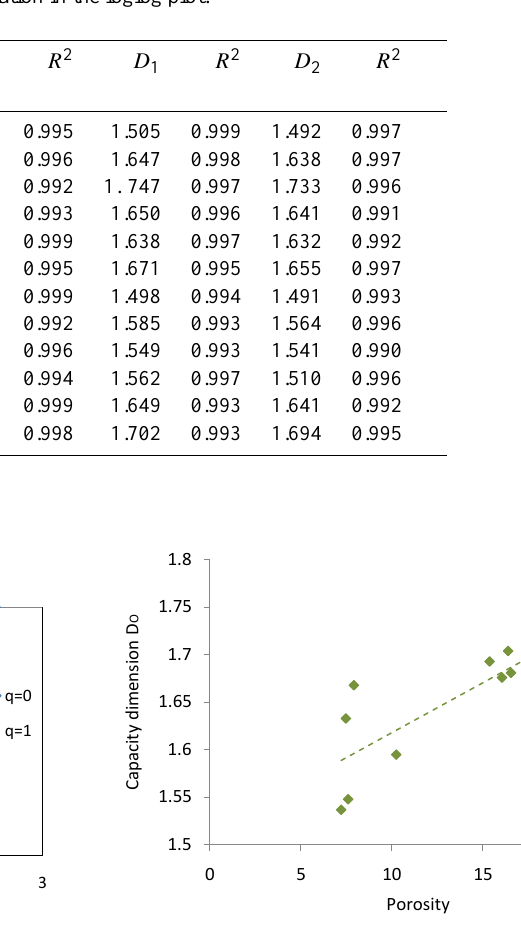
Fig. 8. Linear direct relationship between the capacity dimensions D 0 and porosities for all samples.